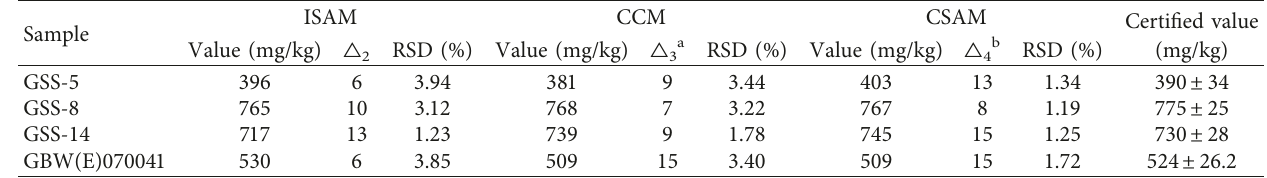
Table 6: Comparison of the determined results of ISAM, CCM, and CSAM.